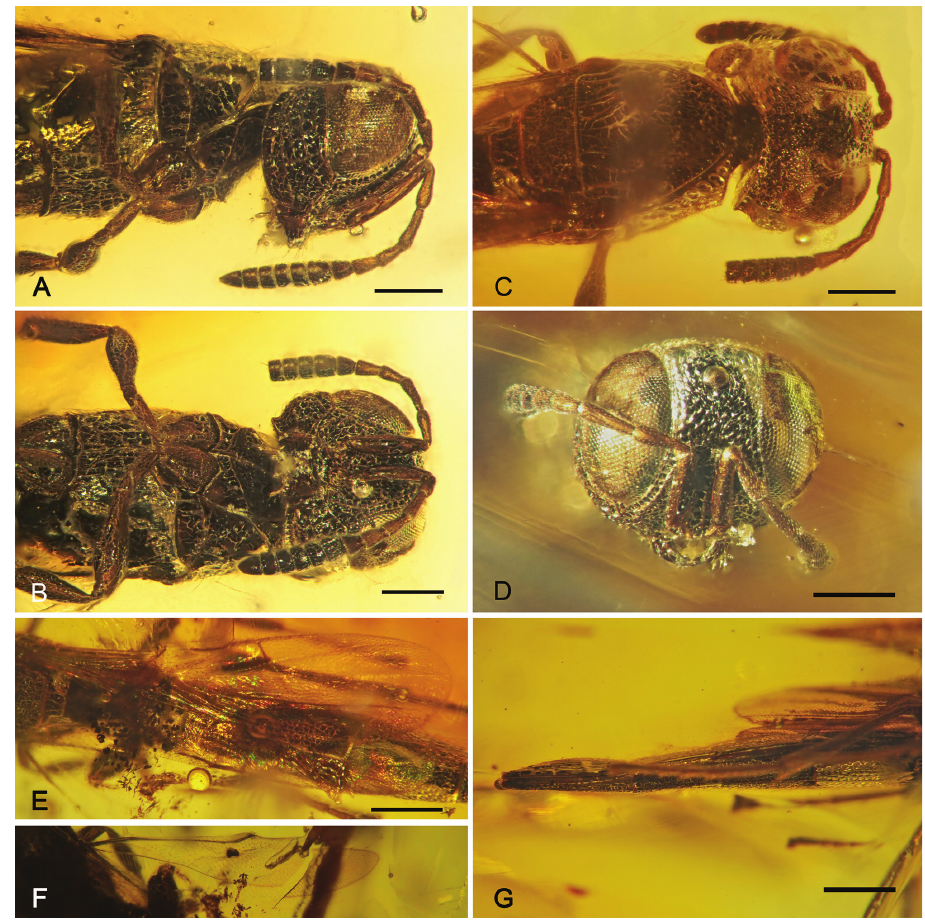
Figure 2. Macroteleia yaguarum Perrichot & Engel, sp. n., holotype MUSM-A-2006-4a, female A Head and mesosoma in lateral view B Head and mesosoma in ventral view C Head and mesosoma in dorsal view D Head in full face view E Forewing F Hind wing G Metasomal segments 4–6 in lateral view. Scale bars: A–D : 0.25 mm; E–G : 0.5